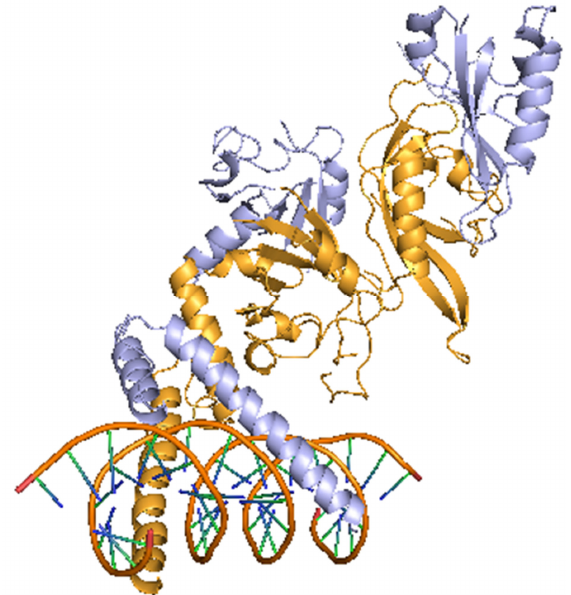
Figure 2. Structure of HIF-1 α and HIF-1 β . This image is a crystal structure of the heterodimeric HIF-1 α and HIF-1 β complex. Light yellow color indicates HIF-1 α , light purple color indicates HIF-1 β , and orange color indicates DNA. Modified from PDB ID: 4ZPR [23].